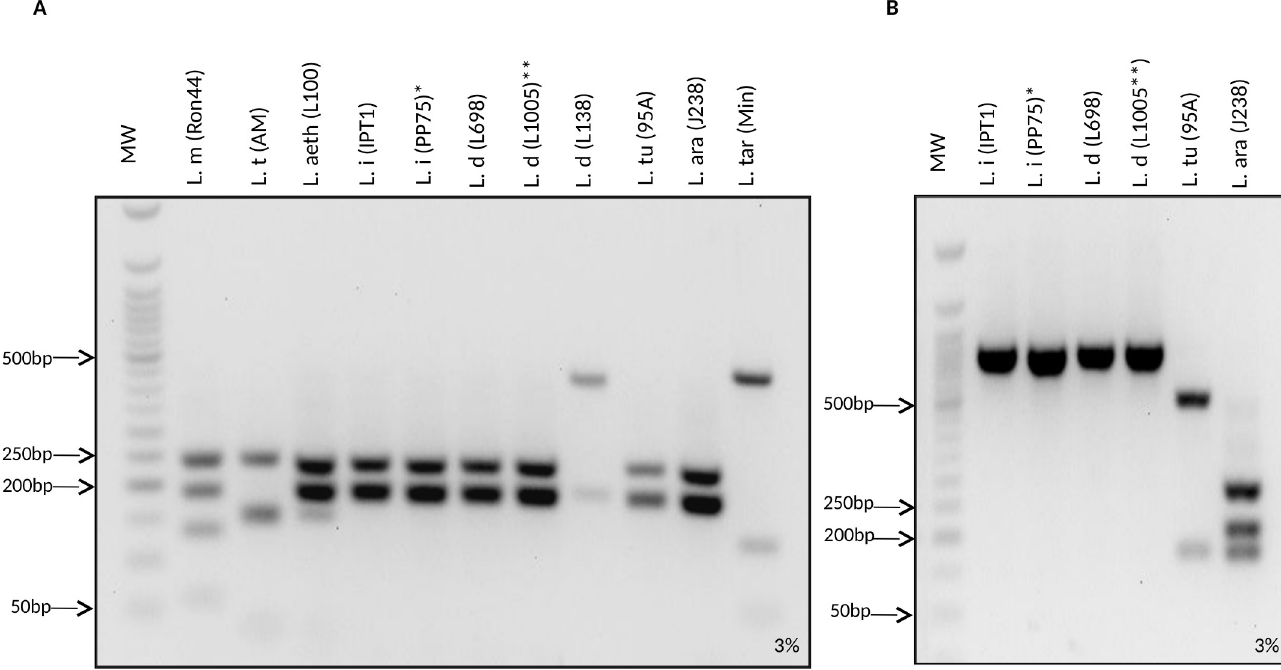
Fig 6. ( A) RFLP patterns of the Hae III/ Kpn I double digested, amplified DPPIII fragments. L . major , L . tropica , L . aethiopica , L . tarentolae , and Indian L . donovani presented distinctive profiles while African and Middle Eastern L . donovani , L . infantum , L . turanica and L . arabica shared the same patterns. (B) RFLP patterns of the Pvu II/ Sac I double digested, amplified DPPIII fragments. The L . infantum , L . arabica and L . turanica DNAs were distinguished by their PCR- RFLP profiles. The African and Middle Eastern L . donovani and L . infantum DNAs presented the same patterns. MW: 50bp Molecular Weight. L . m : L . major; L . t : L . tropica; L . ae : L . aethiopica; L . i : L . infantum; � Brazilian L . infantum strain (also known as L . chagasi ) ; L . d : L . donovani; � East African L . donovani strain (also known as L . archibaldi ) ; L . tu : L . turanica; L . ar : L . arabica; L . tar : L . tarentolae